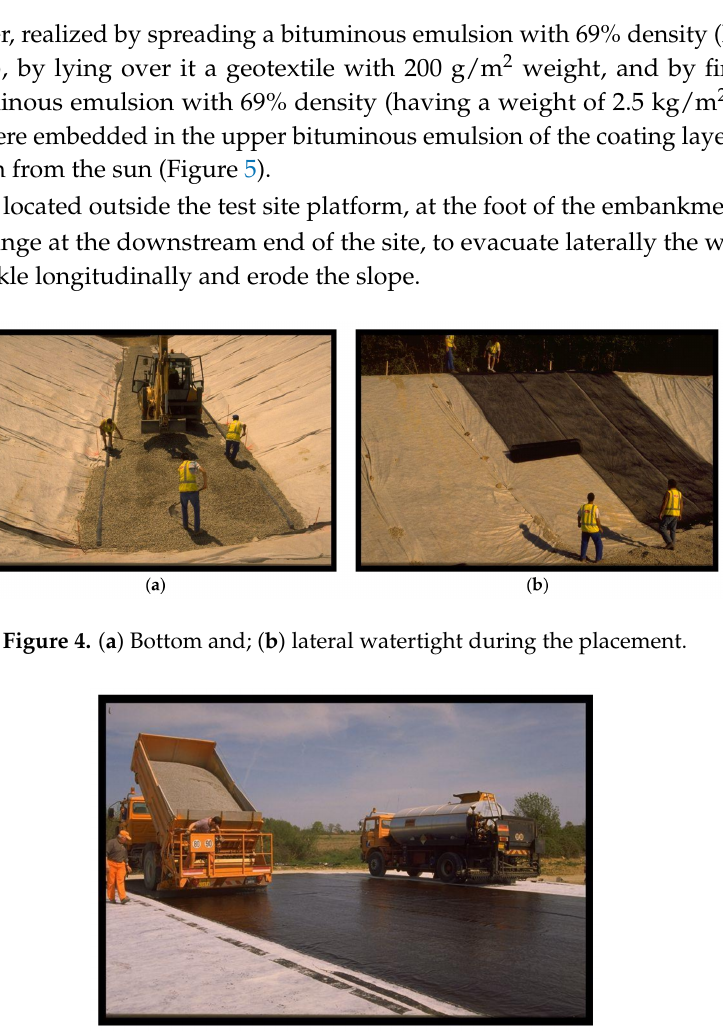
Figure 5. Placement of the 3-layer asphalt wearing.